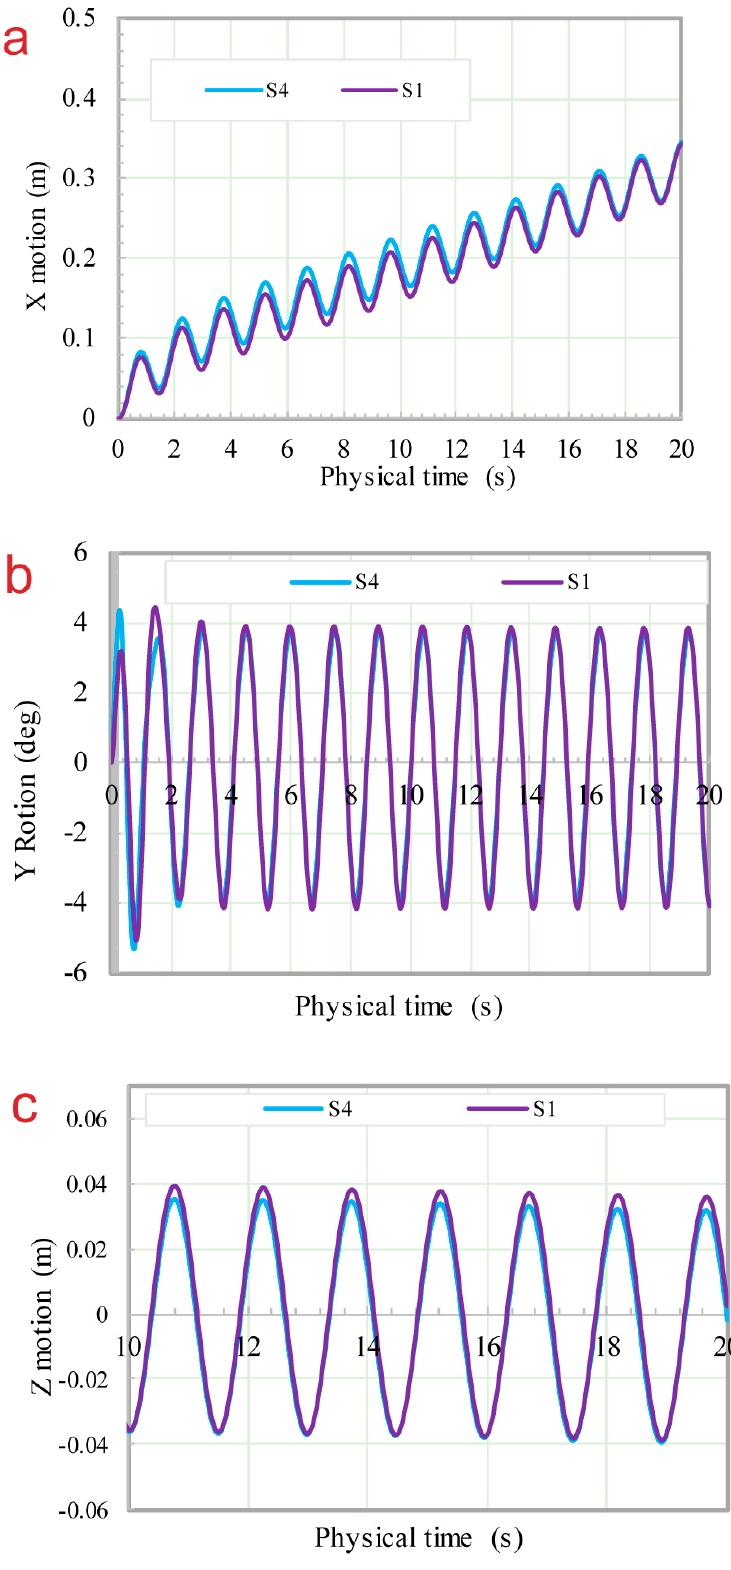
Figure 11. Motions of ice floes along x, y, and z directions in different ice thicknesses. ( a ) X motion of ice floe; ( b ) Y rotation of ice floe; ( c ) Z motion of ice floe.